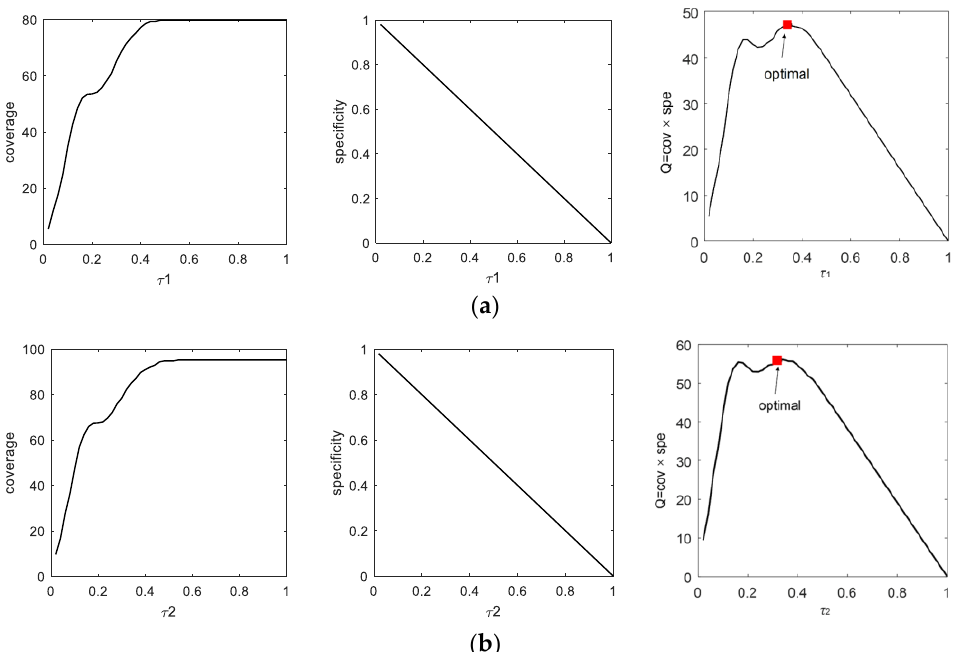
Figure 4. Variances of coverage, specificity and their product. ( a ) τ 1 ; ( b ) τ 2 .